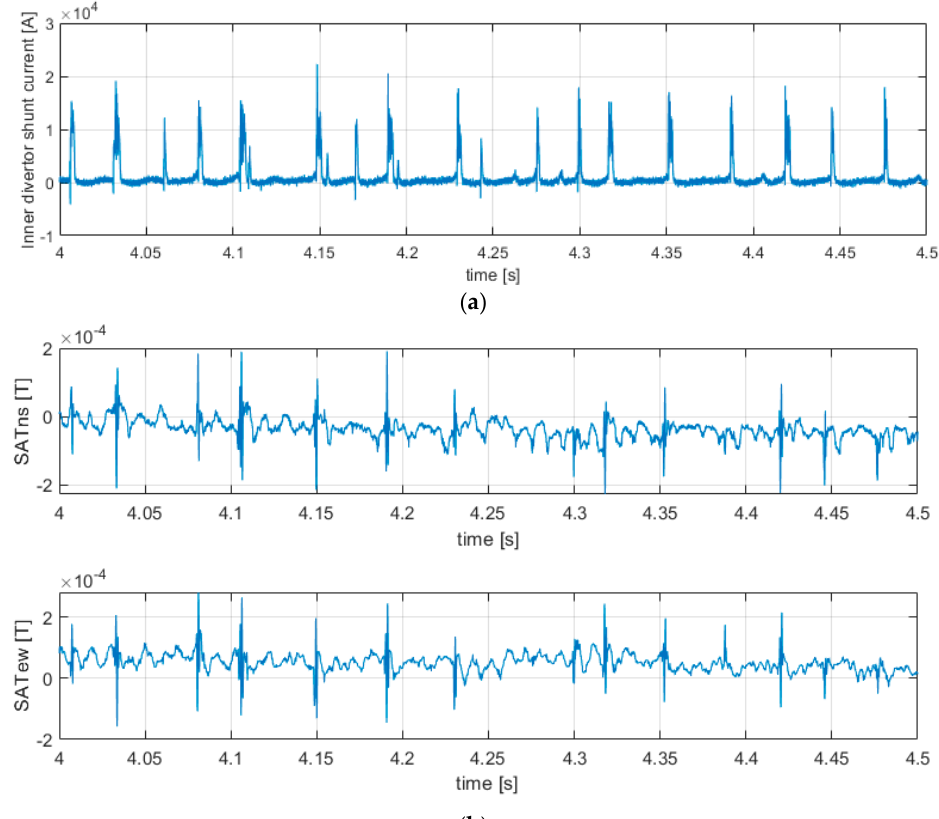
Figure 3. Illustrative example for an Edge localized model (ELMy) phase of the pulse 30492. ( a ): Inner divertor shunt current; ( b ) integrated difference of π -opposed coils (ns and ew respectively).